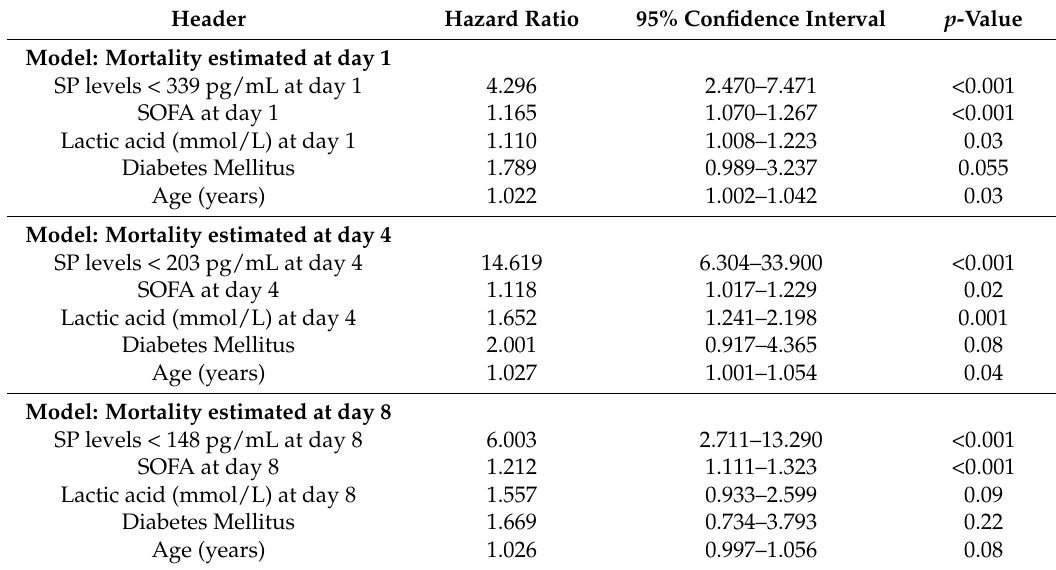
Table 5. Multiple logistic regression analyses to predict mortality at 30